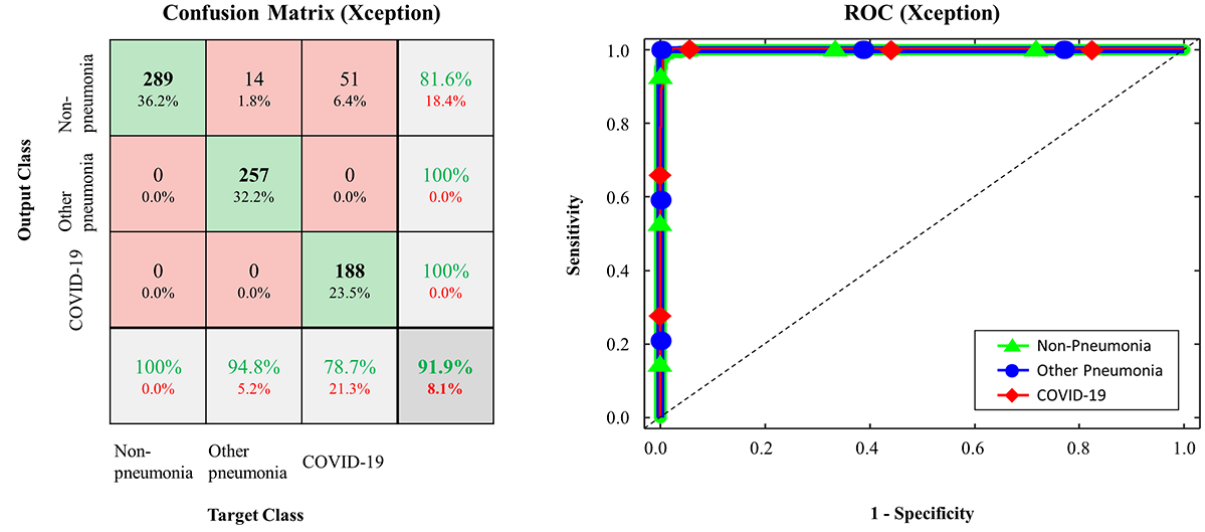
Figure 4. Confusion matrix and ROC curve in FCONet using Xception; COVID-19: coronavirus disease; ROC: receiver operating characteristic.